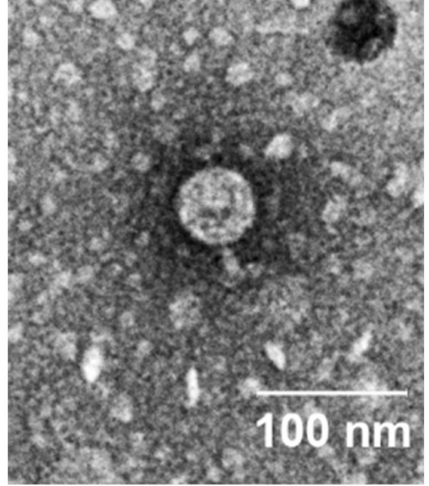
Figure 1. Electron micrograph image of phage SALSA infecting S. marcescens , negatively stained with 1% phosphotungstic